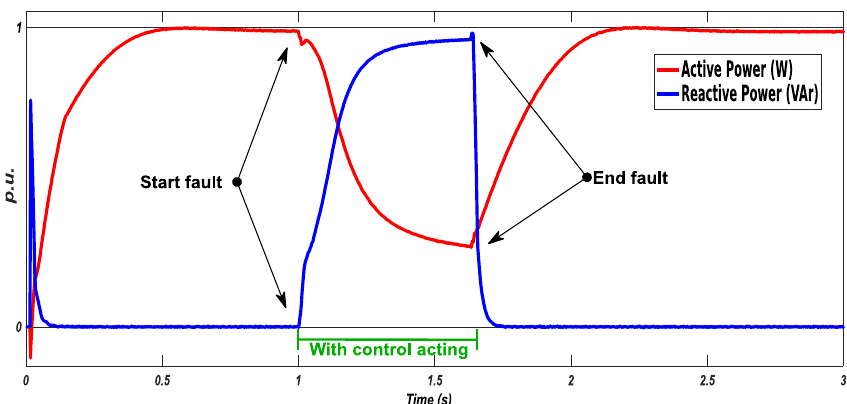
Figure 1. Proposed control to the injection of active and reactive power during the voltage sag.